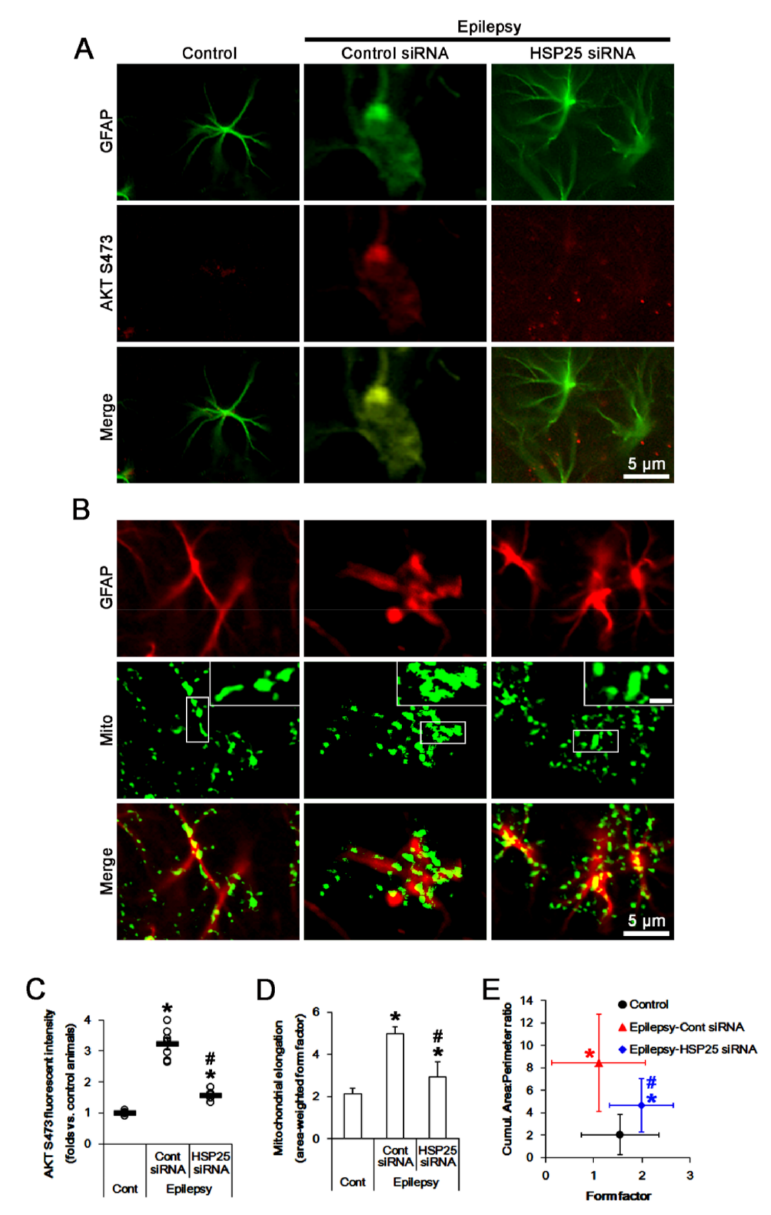
Figure 5. Effects of HSP25 knockdown on AKT S473 phosphorylation and mitochondrial length in CA1 astrocytes of control and epileptic rats. As compared to control animals (Cont), AKT S473 phosphorylation and mitochondrial length are increased in CA1 astrocytes in epileptic rats. HSP25 siRNA reduces AKT S473 phosphorylation and mitochondrial length in CA1 astrocytes, as compared to control siRNA (cont siRNA). ( A , B ) Representative photos demonstrating astroglial AKT S473 phos- phorylation ( A ) and mitochondrial morphology ( B ) in CA1 astrocytes. ( C – E ) Quantifications of AKT S473 phosphorylation (mean ± S.E.M.; *, # p < 0.05 vs. control and control siRNA-treated epileptic rats, respectively; n = 7, respectively, ( C )), mitochondrial elongation index (area-weighted form factor, mean ± S.E.M.; *, # p < 0.05 vs. control and control siRNA-treated epileptic rats, respectively; n = 7, respectively, ( D )) and the cumulative area:perimeter ratio (an indicative of the transition from elon- gated, isolated mitochondria to a reticular network or aggregation of interconnected mitochondria) and the form factor (a parameter as transition from the sphere to elongated, complex shaped, but still isolated mitochondria; mean ± S.E.M.; *, # p < 0.05 vs. control and control siRNA-treated epileptic rats, respectively; n = 7, respectively, ( E